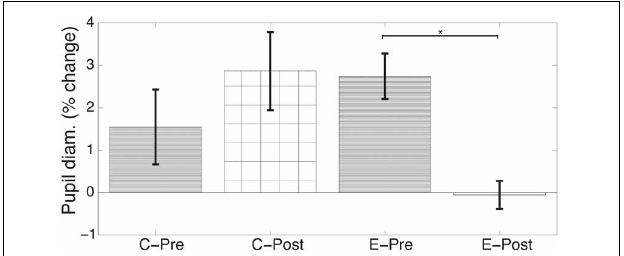
FIGURE 3 | Training abolishes the effect of task difficulty on pupil diameter. Prior to training, both groups (Control, C; and Experiment, E) show increased pupil size during Task 4 relative to Task 2, consistent with an increase in task difficulty. After training, the experimental group shows no significant difference in pupil diameter between Tasks 2 and 4. Repeated measures analysis of variance shows this is a significant effect of training (interaction of Group by Time p < 0 . 03). ∗ p < 0 . 05.